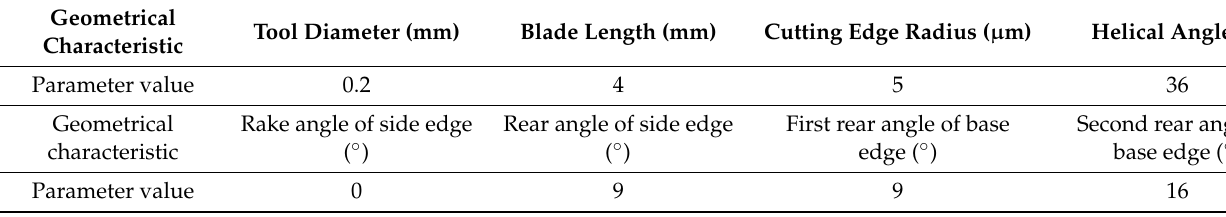
Table 1. Geometrical parameters of Simulation model.